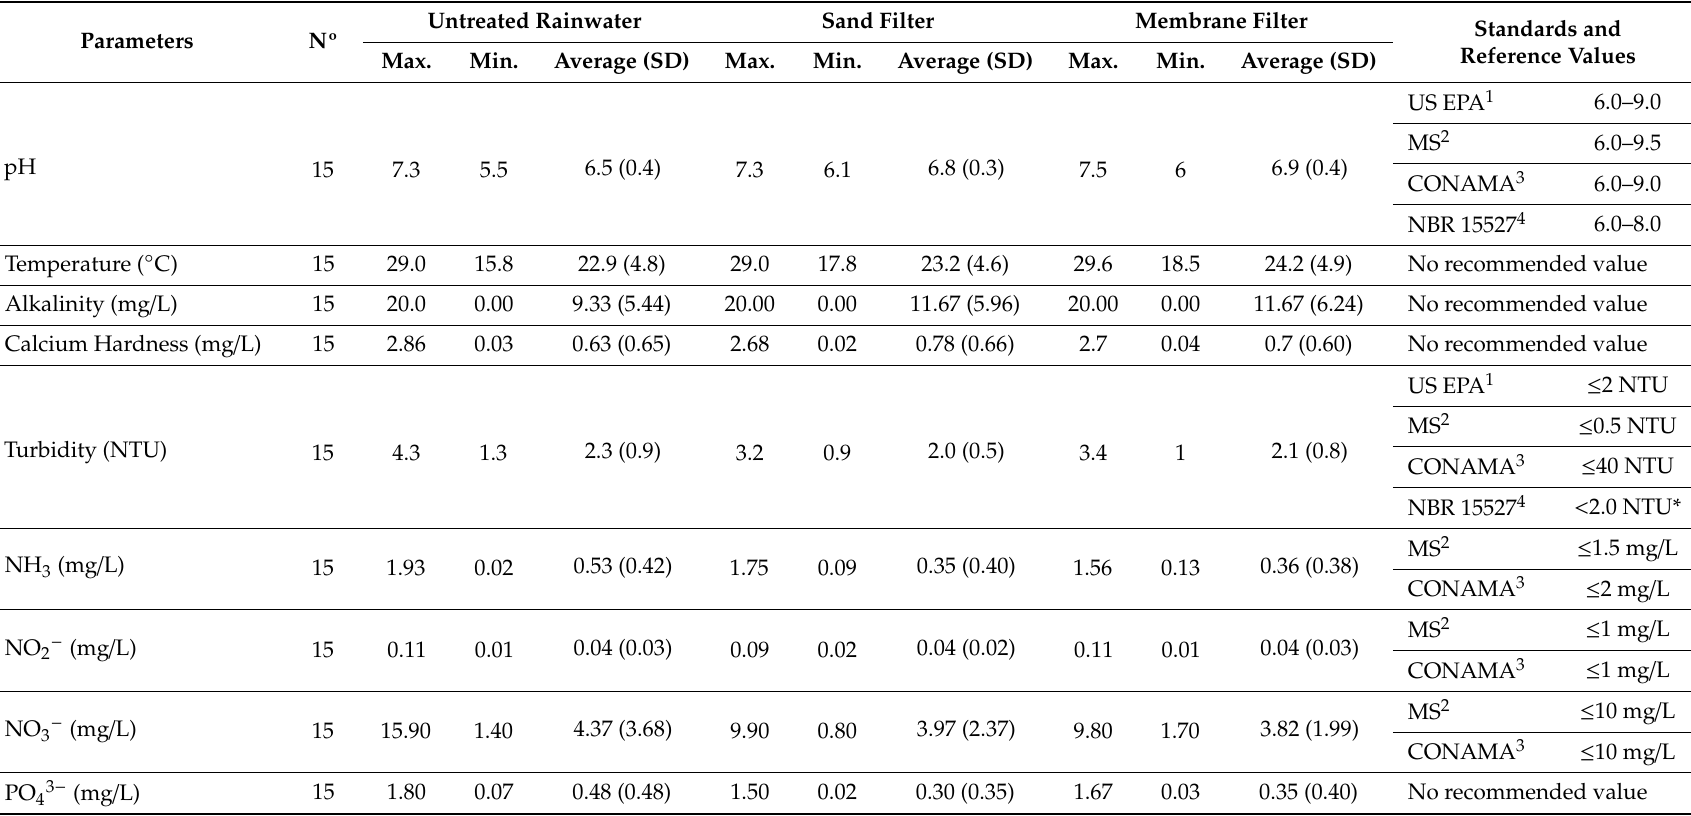
Table 5. Statistical results for the physicochemical analysis of rainwater collected at the sampling points. Untreated Rainwater Sand Filter Membrane Filter Standards and Parameters Nº